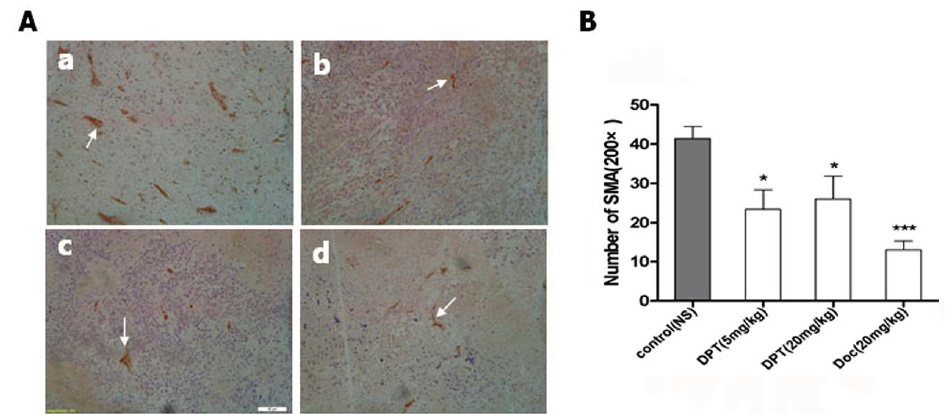
Figure 8. Antiangiogenic effects of DPT on SGC-7901 gastric cancer xenograft. Animals were treated with control, DPT or docetaxel. ( A ) Immunohistochemical analysis of blood vessels (arrow) in tumor tissue from treated animals: ( a ) control; ( b ) Docetaxel, 20 mg/kg; ( c ) DPT, 5 mg/kg; ( d ) DPT, 20 mg/kg. ( B ) Dose-response effect of DPT and docetaxel on tumor vascular density. Each point represents mean ± SEM (n = 3) from a representative